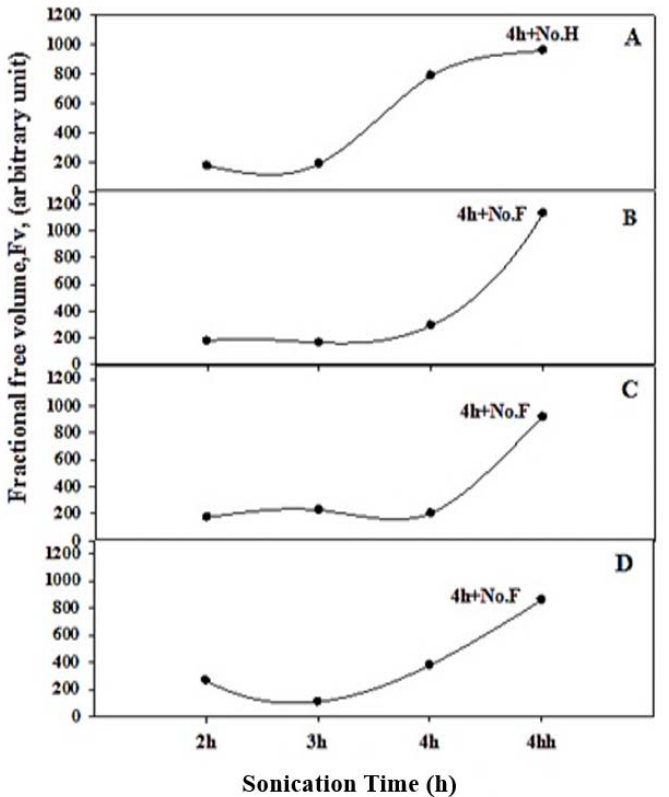
Figure 5. The variation of fractional free volume, Fv, as a function of sonication time (2, 3 and 4 h) in special conditions; 7 g commercial silicon powder in different KOH concentrations (wt.%): ( A ) at 6 wt.% KOH, ( B ) 4.5 wt.% KOH and ( C ) 3 wt.% KOH and ( D ) 5 g commercial silicon powder and 3 wt.%